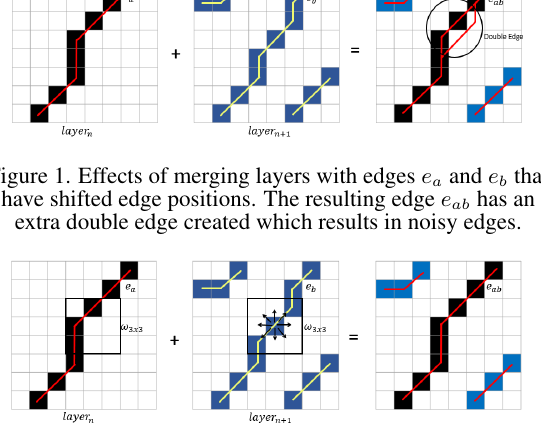
Figure 2. Correct merging is achieved using a localisation filter that ensures no duplicates or double edges. The result is a clean edge map as shown by resulting edge e ab